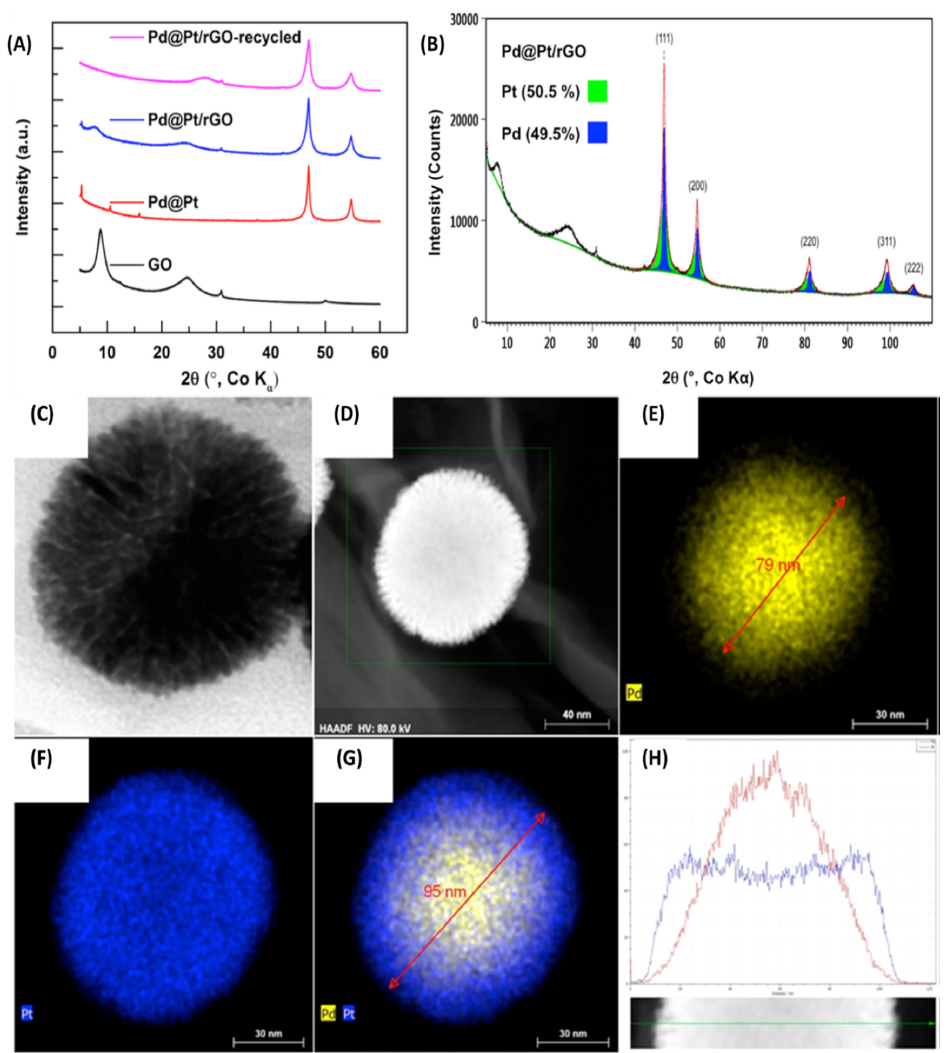
Figure 22. ( A ) PXRD data for GO, Pd@Pt, Pd@Pt/rGO, and Pd@Pt/rGO recycled samples; ( B ) Reitveld refined spectra of Pd@Pt/rGO with Pt and Pd shown in green and blue; ( C ) HRTEM image; ( D ) HAADF-STEM image; ( E , F ) 2D mapping results with Pd counts (yellow), and Pt counts (green); ( G ) overlay; ( H ) line scan analysis with Pt (blue), and Pd (red). Adapted with permission from the American Chemical Society. Copyright 2017 American Chemical Society.